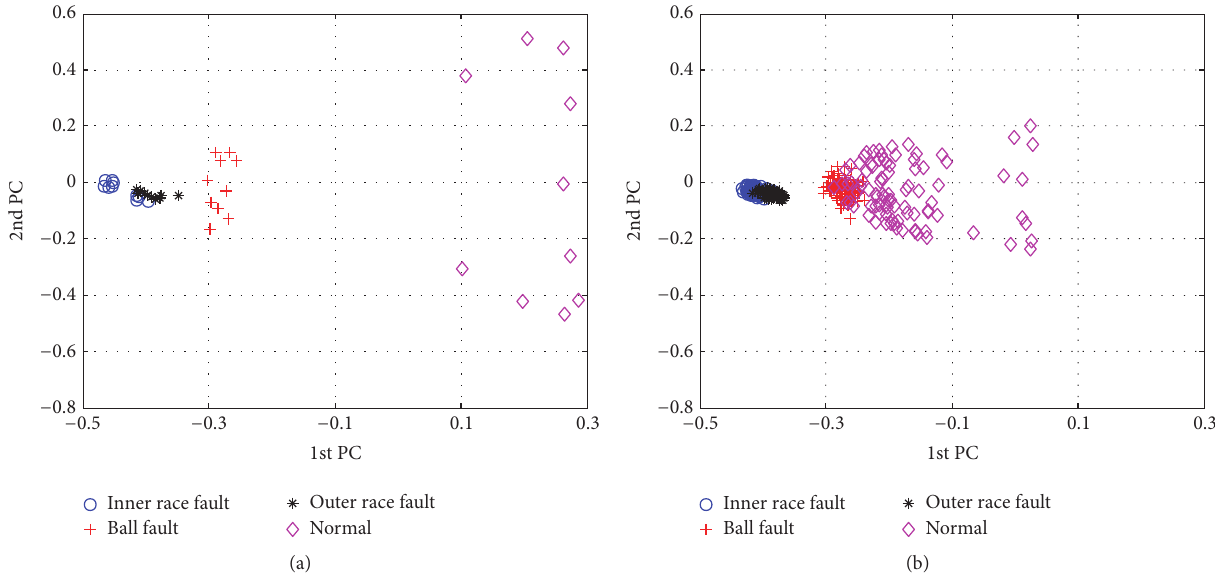
Figure 5: Feature extraction with KPCA: (a) training set and (b) testing